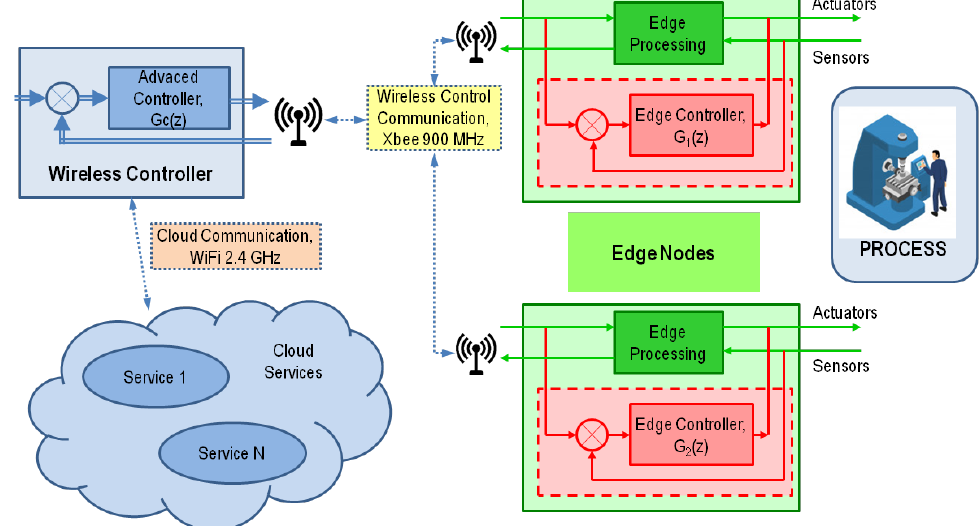
Figure 1. Overall wireless architecture for reliable edge computing.